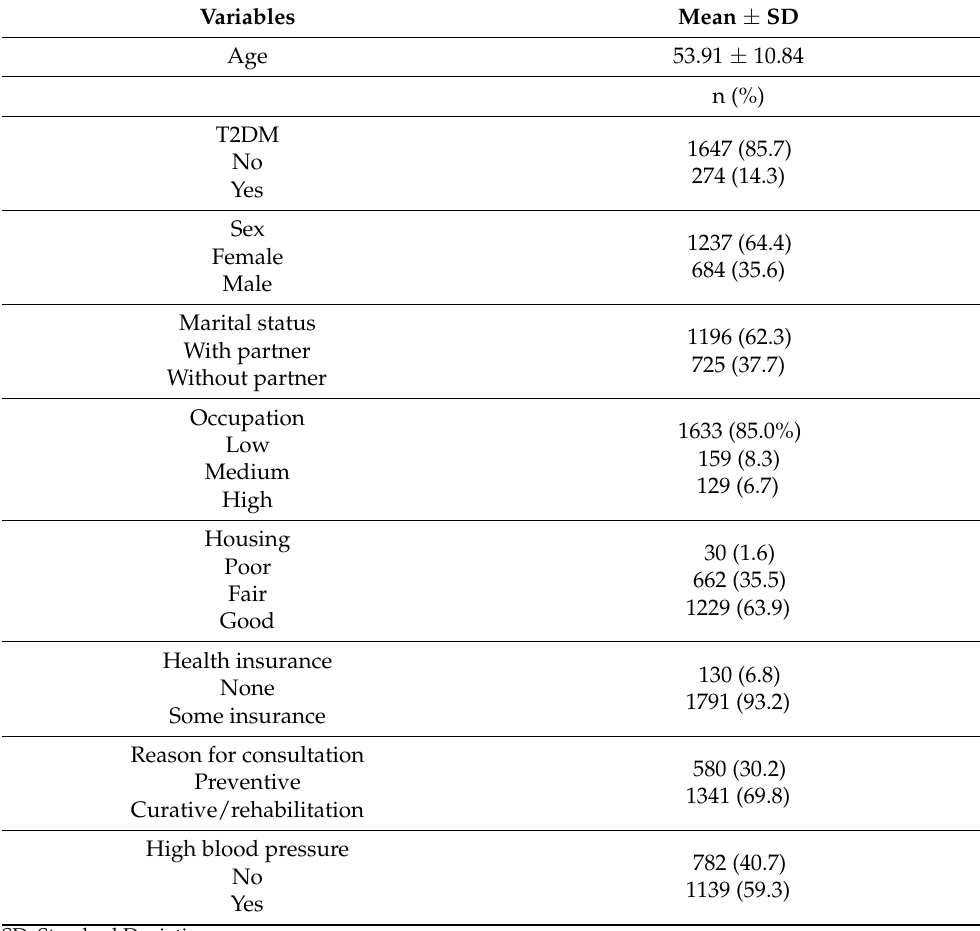
Table 1. Descriptive analysis of the study sample of Mexican adults aged 40 years and